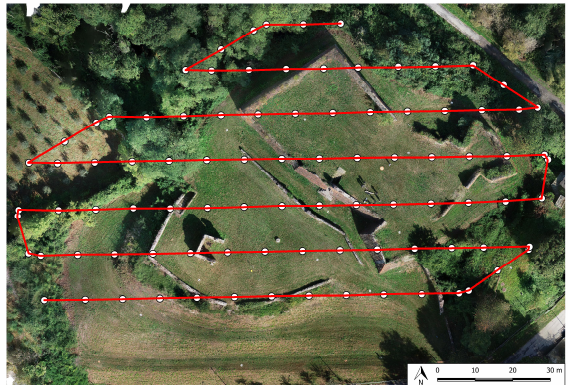
Figure 3 Flight plan for Castellazzo area. Flight lines in red and camera positions highlighted with white dots.